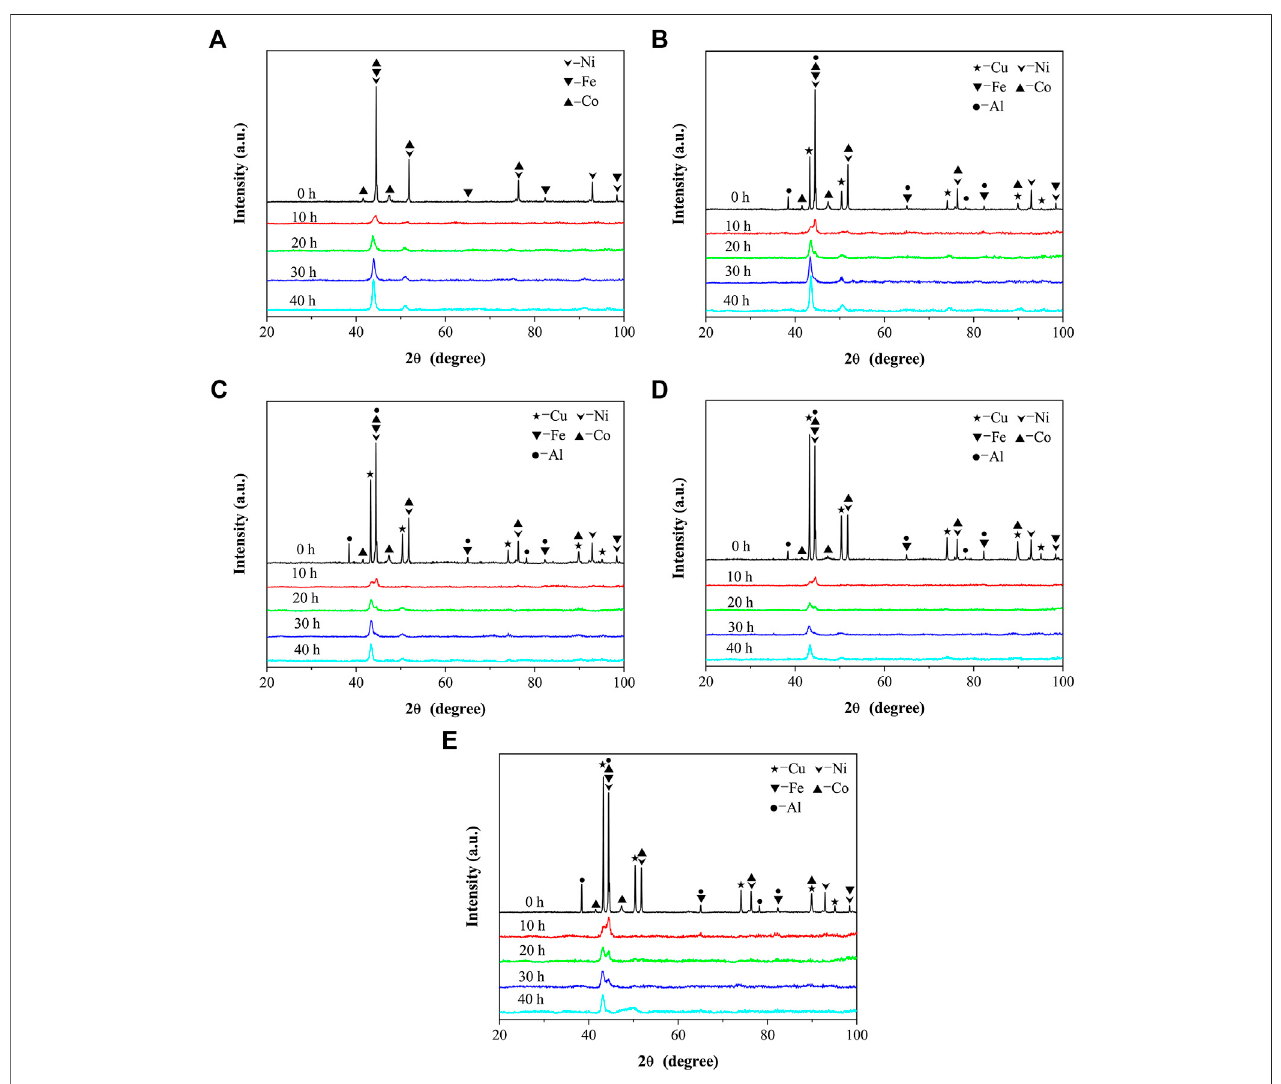
FIGURE 1 | XRD patterns of FeCoNi(CuAl) x MEA and HEA powders with different milling times: (A) x (cid:1) 0; (B) x (cid:1) 0.4; (C) x (cid:1) 0.6; (D) x (cid:1) 0.8; (E) x (cid:1) 1.0.